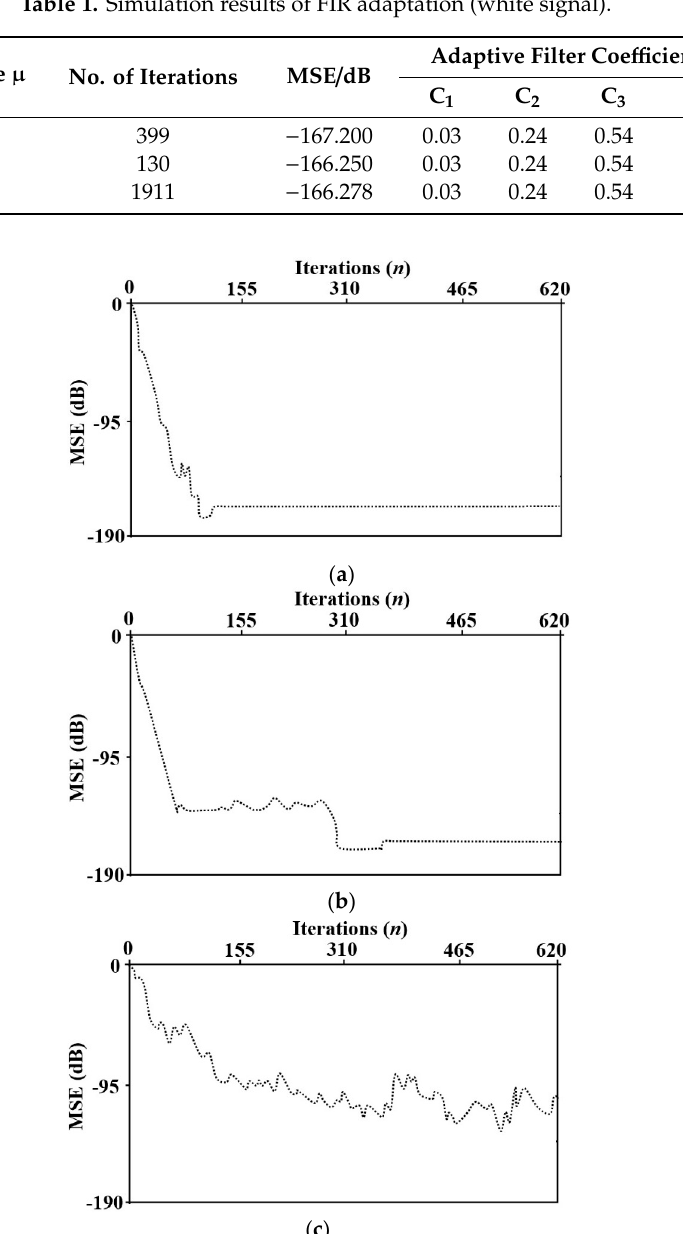
Figure 15. The learning curves for FIR adaptive filter with LMS algorithm: ( a ) 𝜇 = 0.045 , ( b ) 𝜇 = 0.04 , and ( c ) 𝜇 = 0.095 .